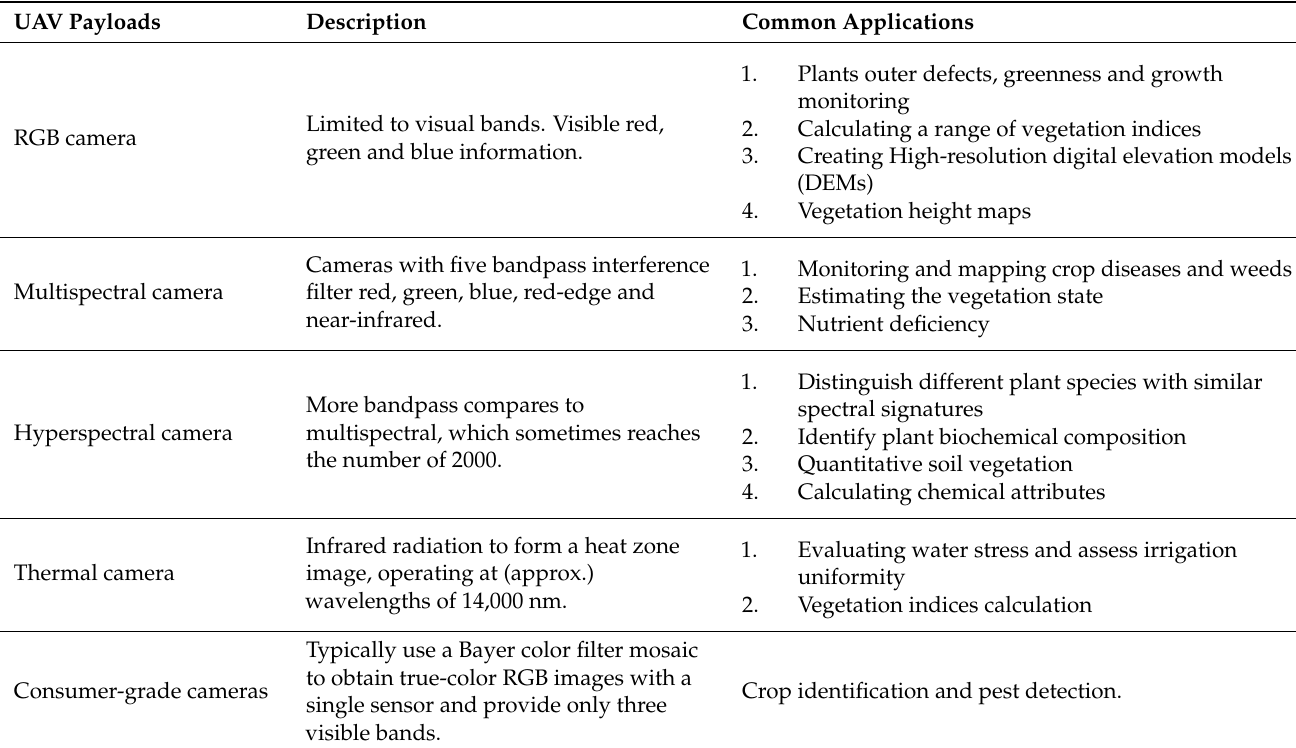
Table 5. The most desired sensors for various PA operations and their